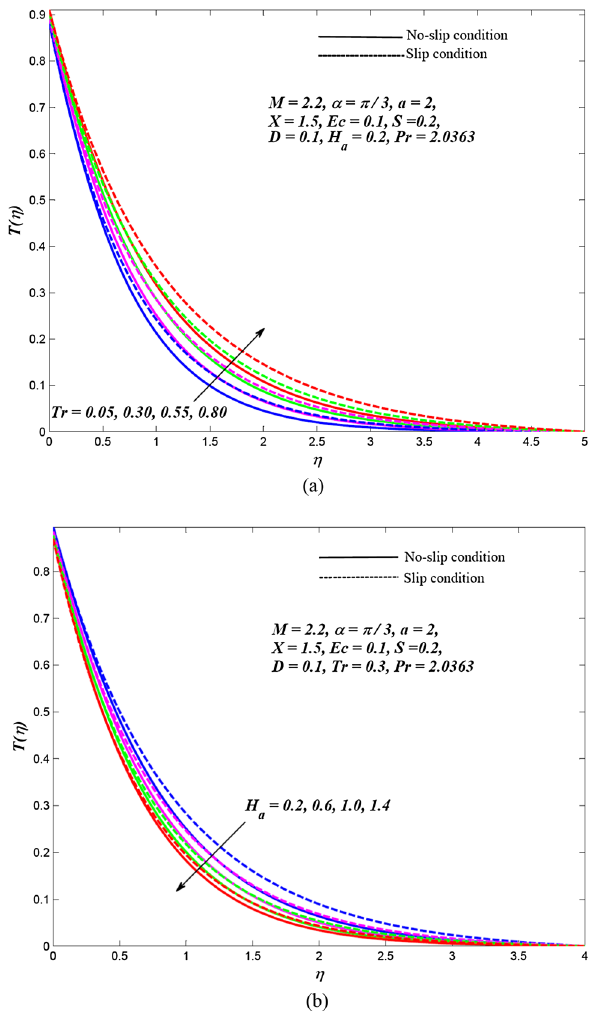
Figure 6. Hybrid temperature dispersal profiles T (η) for varying ( a ) Tr and ( b ) H a